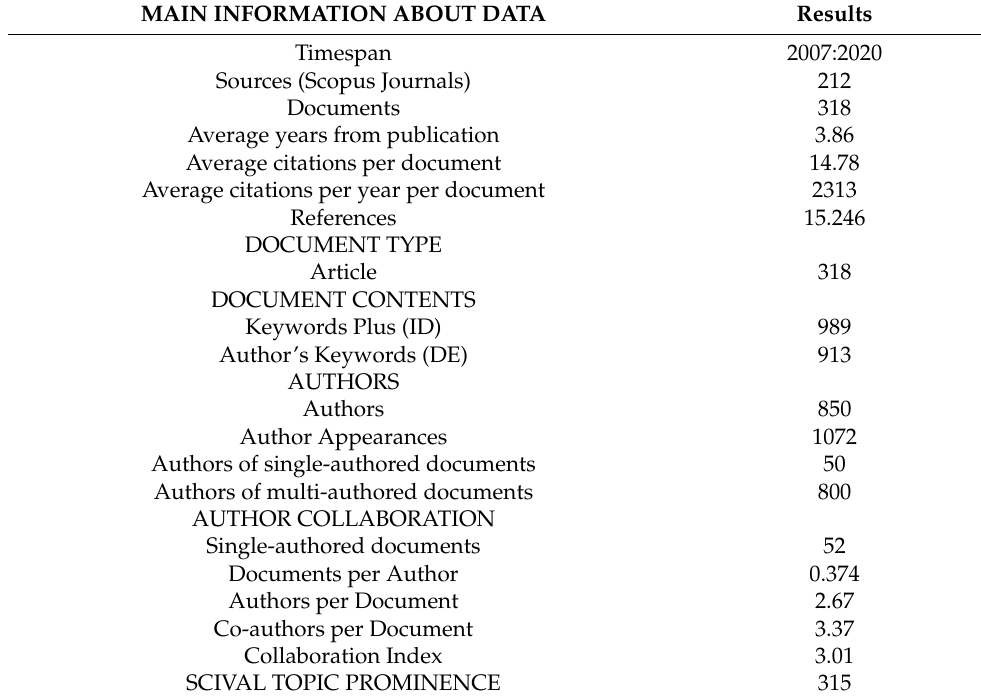
Table 1. Description of Scopus neuromarketing